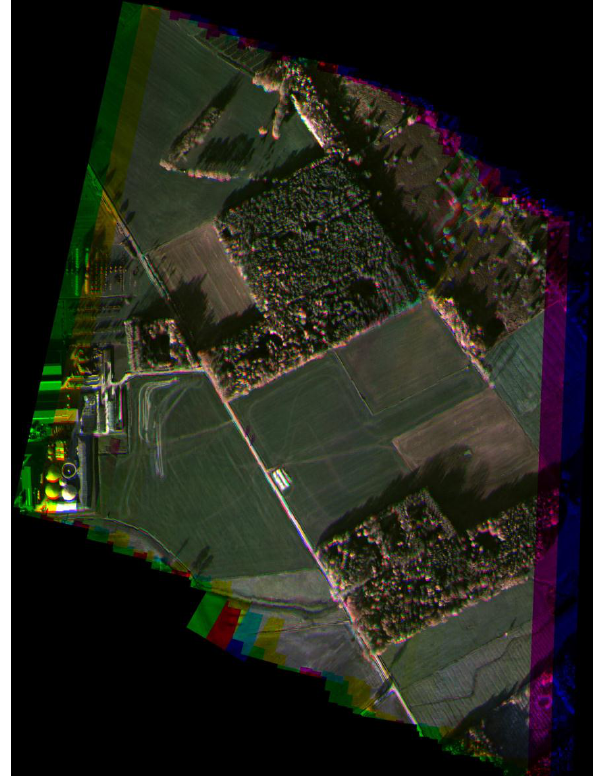
Figure 14 colour image reconstruction of the 3 bands making use of the exterior camera parameters derived from the block bundle adjustment proces applied on the panchromatic data